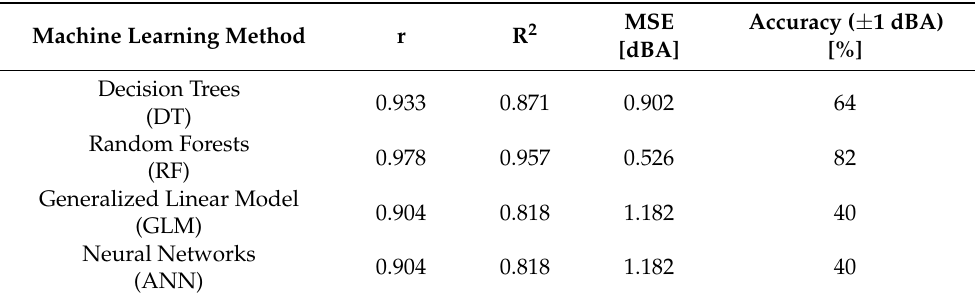
Table 5. Comparison of results for the prediction models in the training phase (without consider- ing honking).